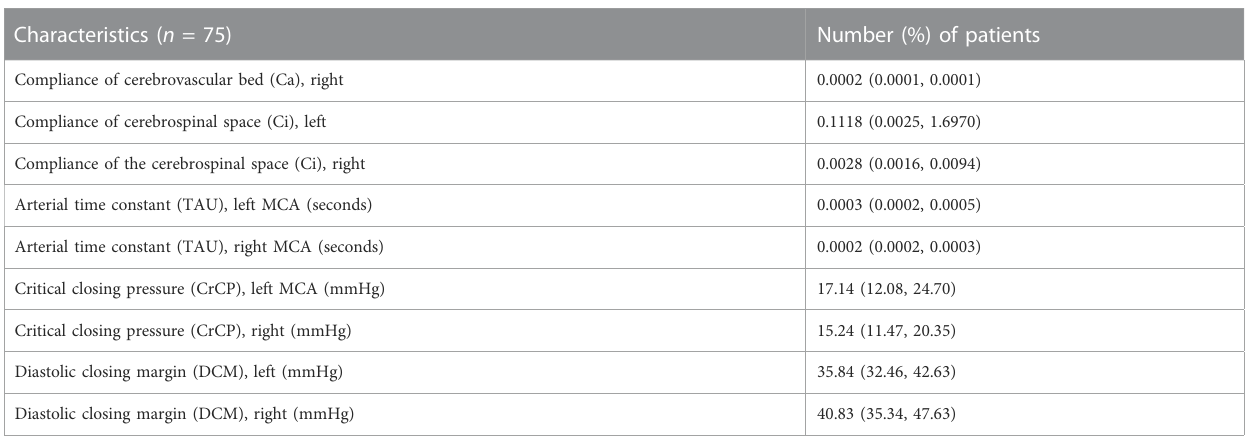
TABLE 3 Association of TCD characteristics with GOSE-Peds scores, 12-month post-injury.